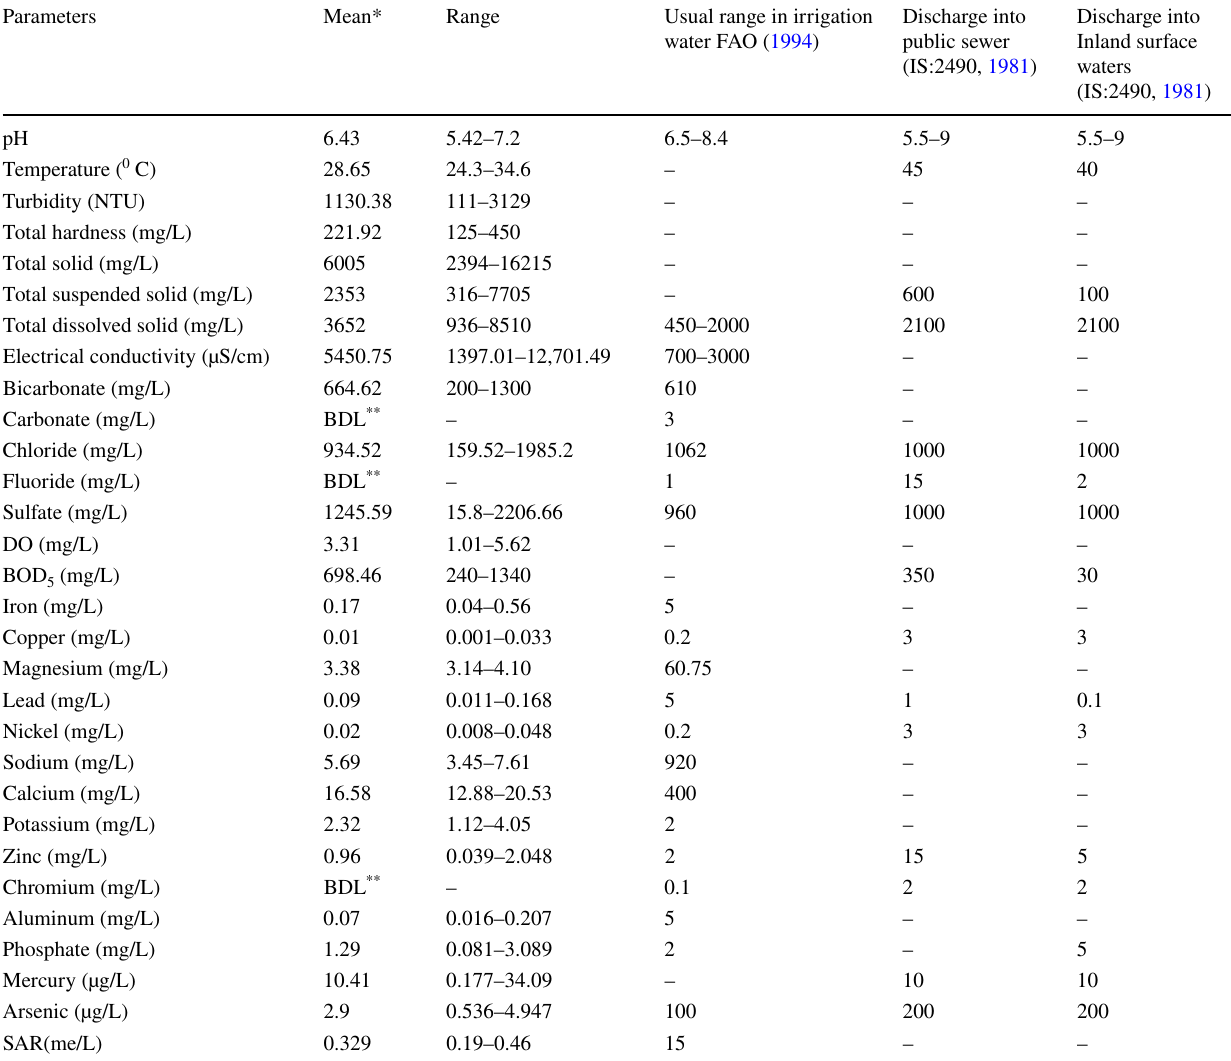
Table 3 Summary of KWW quality parameters compared to standard guidelines